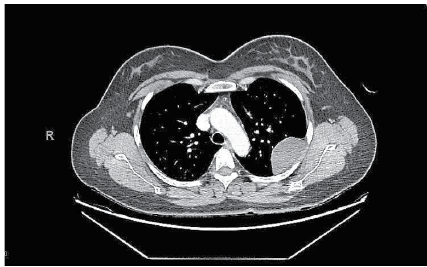
Figure 1: A crescent shaped, pleural based mass, measuring 6 × 4.9 × 3.8 cm, with some modelling and cortical irregularity of the superior aspect of the left lateral fourth rib as seen on CT.